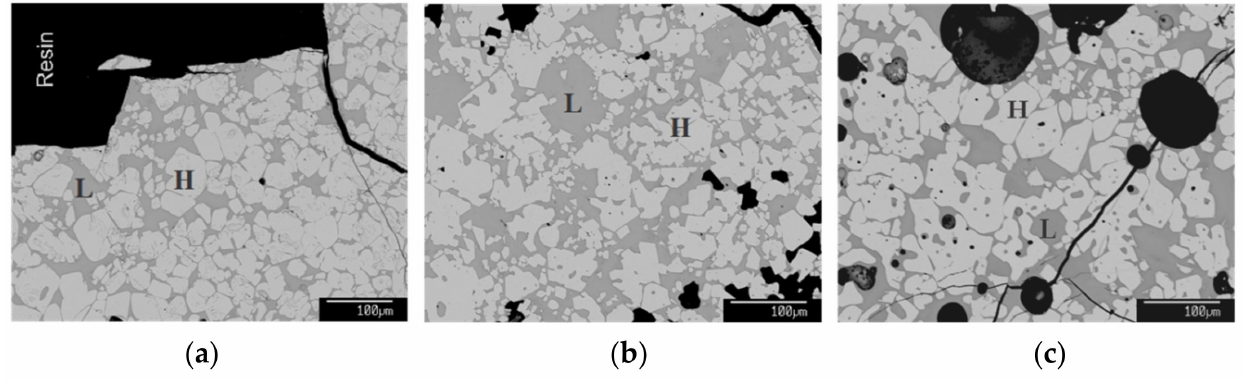
Figure 4. Microstructural BSE images of reheated sinter ‘S2’ at varied peak temperatures. ( a ) 1250 ◦ C, ( b ) 1300 ◦ C, and ( c ) 1350 ◦